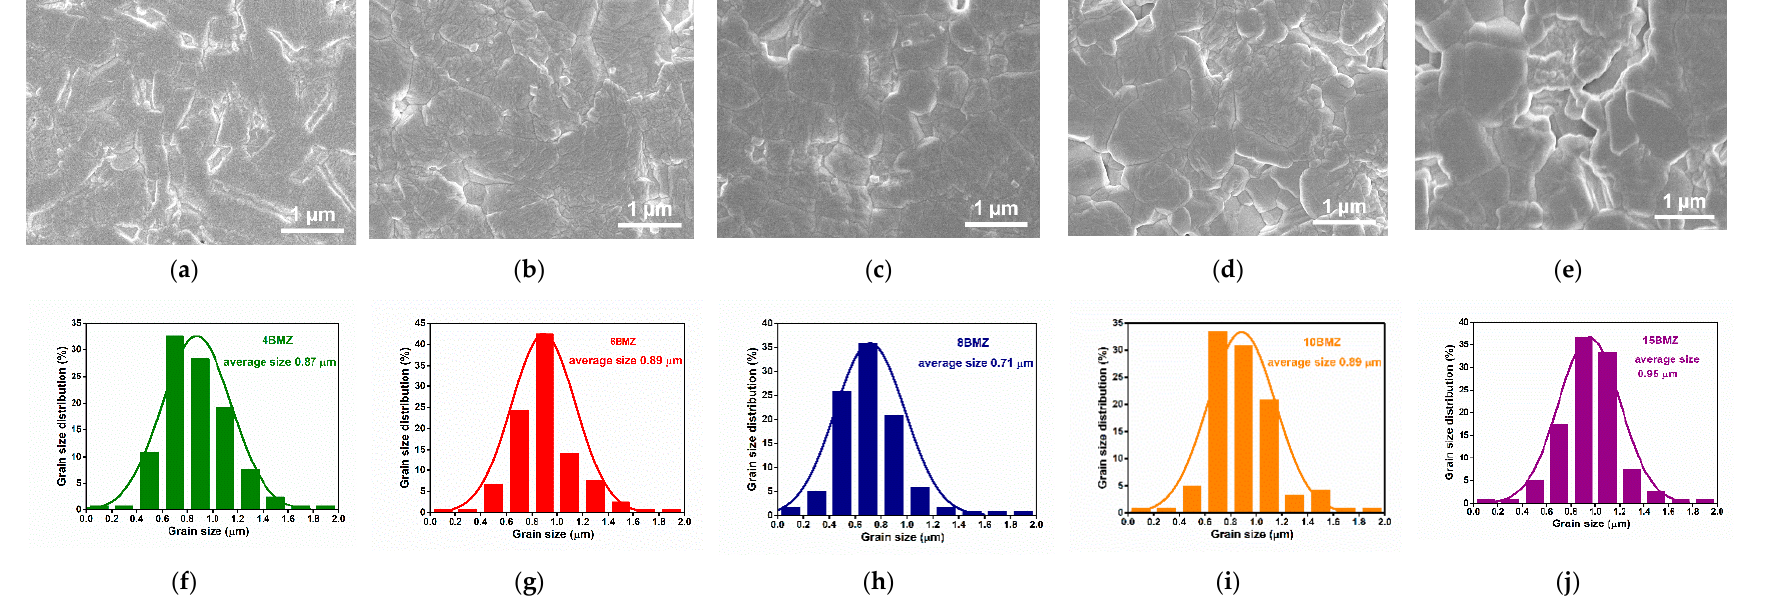
Figure 2. SEM micrographs of the polished and thermally etched surfaces for (1 − x )(Sr 0.7 Bi 0.2 )TiO 3 - x Bi(Mg 0.5 Zr 0.5 )O 3 ceramics: ( a ) x = 4%; ( b ) x = 6%; ( c ) x = 8%; ( d ) x = 10%; ( e ) x = 15%; The grain size of (1 − x )(Sr 0.7 Bi 0.2 )TiO 3 - x Bi(Mg 0.5 Zr 0.5 )O 3 ceramics: ( f ) x = 4%; ( g ) x = 6%; ( h ) x = 8%; ( i ) x = 10%; ( j ) x = 15%.